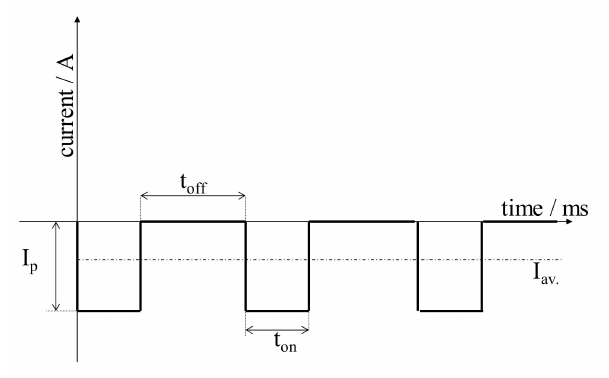
Figure 1. Cathodic square wave current